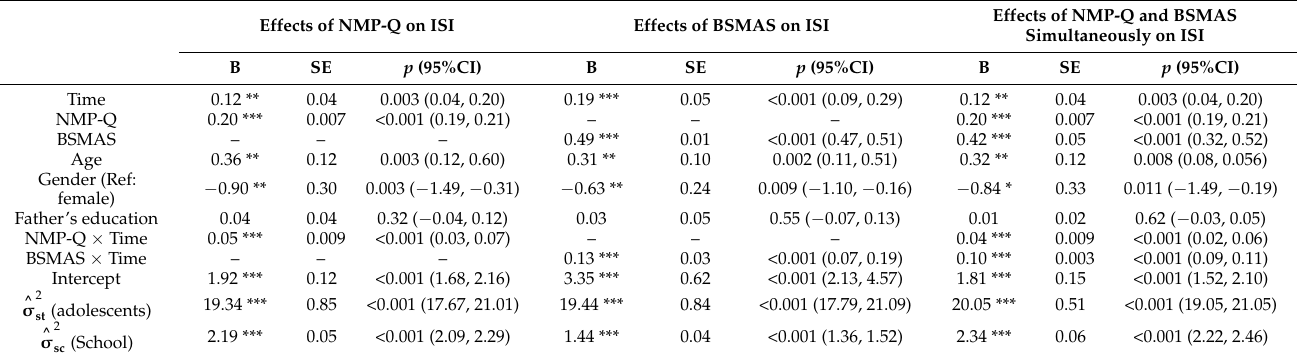
Table 4. Results of the multilevel mixed model analyses with Insomnia Severity Index (ISI) total score as a dependent variable. Effects of NMP-Q on ISI Effects of BSMAS on ISI Effects of NMP-Q and BSMAS Simultaneously on